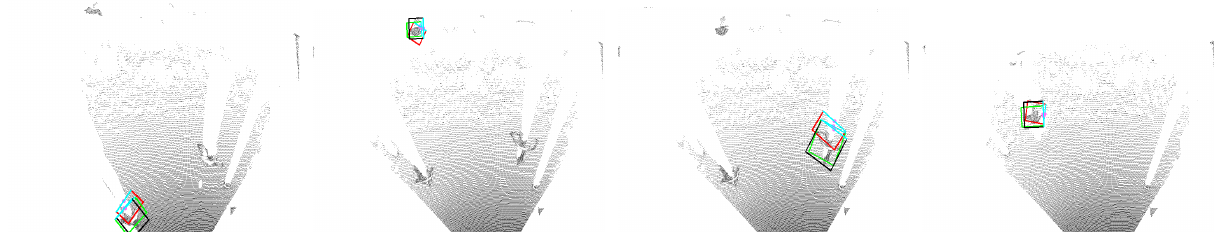
Figure 8. The AP and AOS for different values of IoU threshold for ODR compared against Baseline F-PointNets